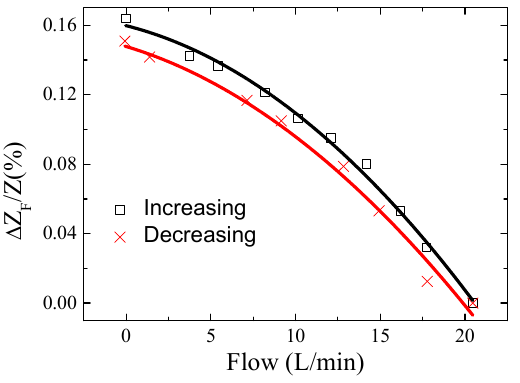
∆ Z ( % ) , as a function of the water flow. F Z ∆(cid:3027) (cid:3255) (%) , as a function of the water flow. (cid:3027)